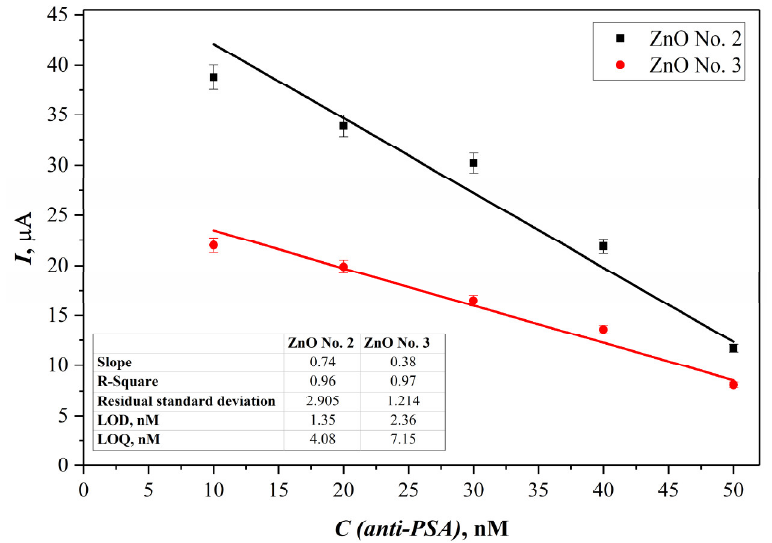
Figure 8. Calibration curves obtained from current SPCE/ZnO-Nafion No. 2 and SPCE/ZnO-Nafion No. 3 peak values, respectively, vs. anti-PSA concentration. Error bars are calculated as a percentage of standard error ( n = 4).